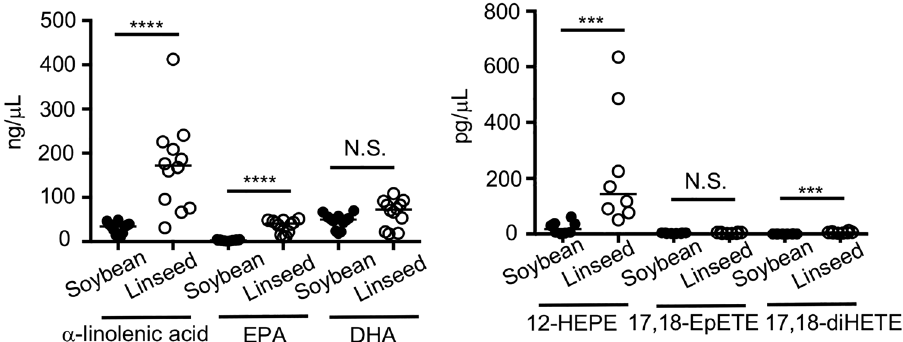
Figure 4. Dietary linseed oil increased the amount of 12-HEPE in serum. Mice were fed with either HFD with soybean oil or HFD with linseed oil for 6 months, and serum was examined by LC–MS/MS for the quantification of fatty acid metabolites. Data are combined from 2 independent experiments. Each point represents data from individual mice; n = 8–12/group. Center values indicate median. Statistical significance of differences was evaluated by means of Mann–Whitney test; **** p < 0.0001; *** p < 0.001; N.S. not